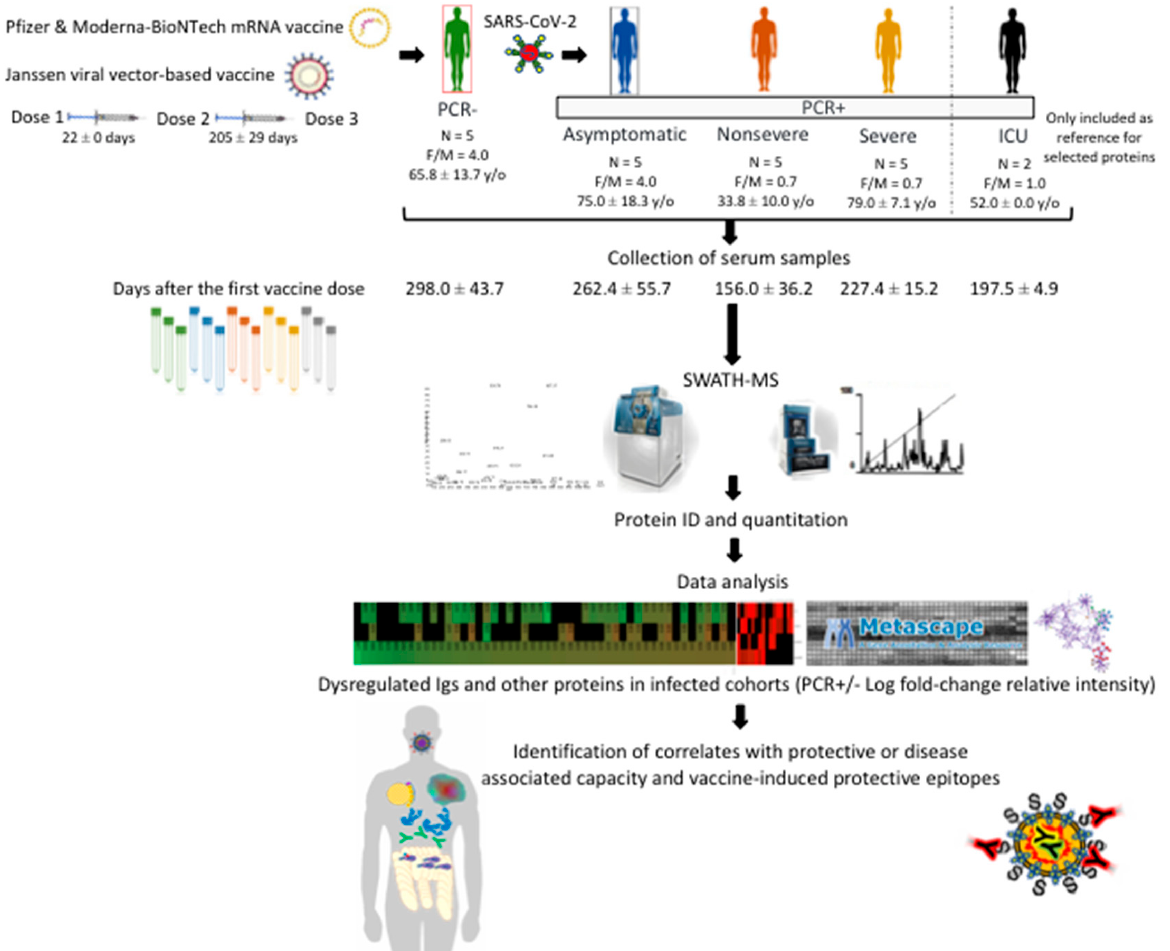
Figure 1. Experimental design and rationale. The experimental design used in our study was based on sera collected from vaccinated individuals (mostly with Pfizer and Moderna-BioNTech) and SARS-CoV-2 PCR-negative (PCR–) or infected PCR-positive (PCR+) and with asymptomatic, non-severe, and severe COVID-19 symptomatology (Table 1). Two PCR+ cases with severe symptoms and in the hospital intensive-care unit (ICU) were included only as reference for selected